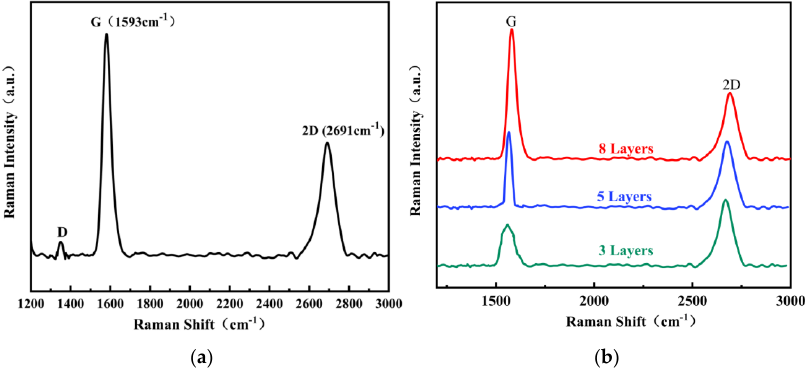
Figure 15. t = 270 s Raman spectrum of graphene: ( a ) without the Tesla valve structure; ( b ) with the Tesla valve structure.